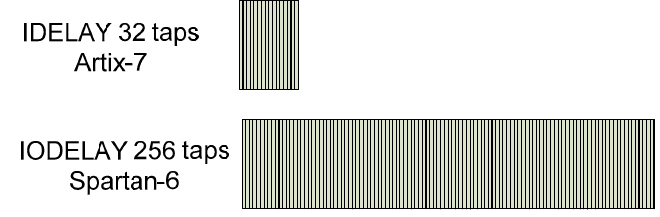
Figure 9. Comparison between IODELAY Spartan-6 FPGA and IDELAY 7-series FPGA.